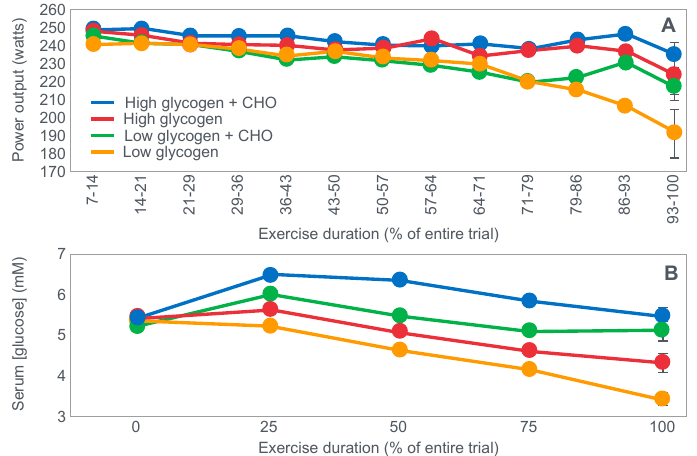
Figure 20. Power outputs (panel A ) and serum glucose concentrations (panel B ) in subjects perform- ing a 70 km cycling trial under four different conditions of starting muscle glycogen contents (high or low) and ingestion during exercise (placebo or 9% carbohydrate solution). Adapted with permission from ref. [71]. Copy-right Year 1993 American Physiological Society.